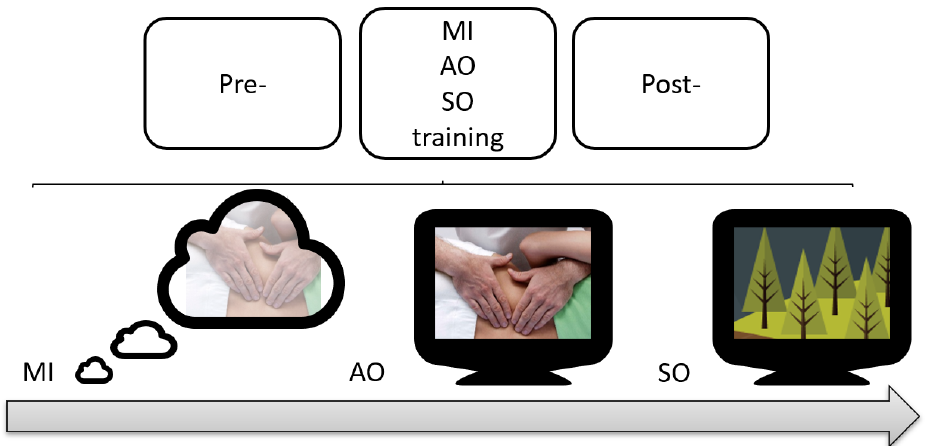
Figure 2. An illustration of the second phase interventions.